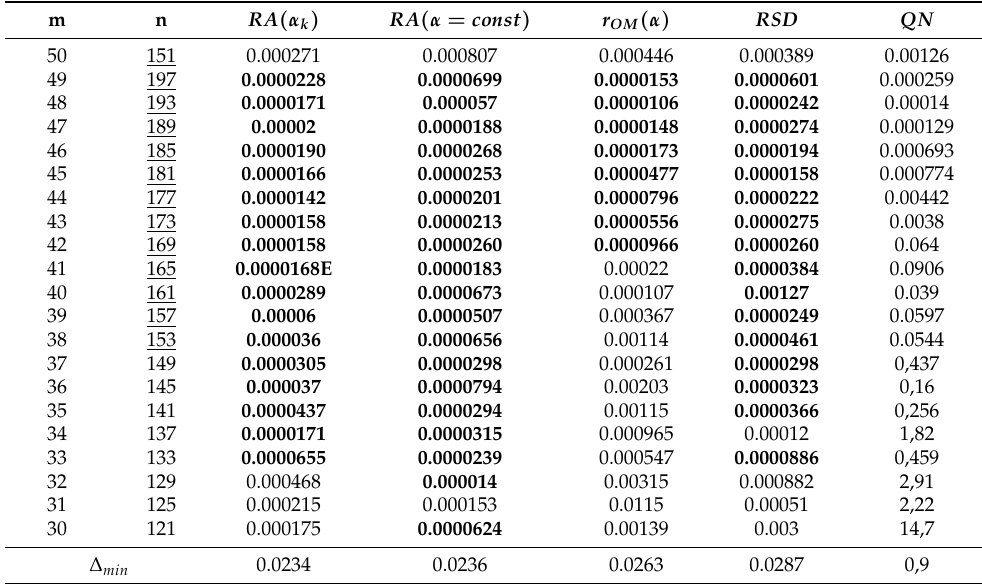
Table 8. Results of function f 6 ( x ) approximation by a sigmoidal ANN with a regularizer R 2 ( w )